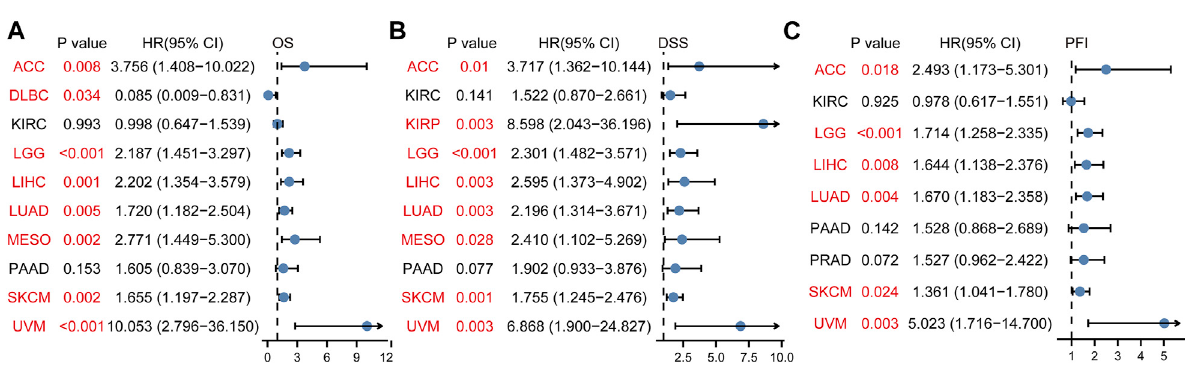
FIGURE 8 Cox regression analyses of DTYMK in TCGA pan-cancer. (A) Forest map indicated the Cox regression results of DTYMK for OS. (B) Forest map indicated the Cox regression results of DTYMK for DSS. (C) Forest map indicated the Cox regression results of DTYMK for PFI. Red colors mean signi fi cant